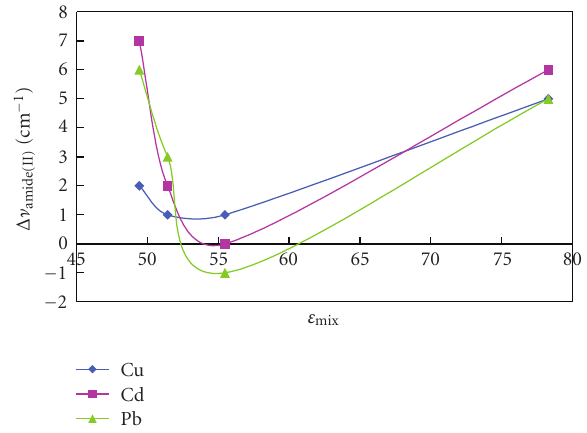
Figure 5: Change in amide(II) bands with e mix .